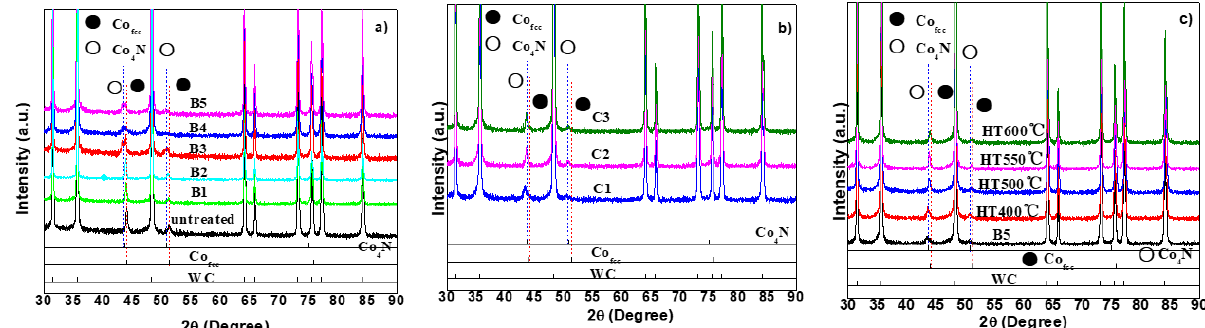
Figure 3. XRD patterns of the ( a ) and ( b ) plasma-nitrided specimens and the ( c ) annealed specimen B5#. Figure 4 presents the XPS core-level spectra of specimen B5#; the spectra of the other specimens were similar. The peaks centered at binding energies of 781.03 and 796.83 eV in Figure 4a correspond to Co 2p 3/2 and Co 2p 1/2 of the Co compounds, respectively [36–38]. The peak corresponding to metallic Co (~778 eV) was not observed in the Co 2p spectrum, indicating the complete conversion of Co present on the surface to Co 4 N after plasma nitriding [39]. In the N 1s spectrum, the peak at 397.12 eV corresponds to the Co-nitrides and that at the 399.28 eV peak originates from the absorption of NH x or N 2 [39,40]. This suggests that Co–N bonds are dominant on the surface. Therefore, the thickness of the top Co 4 N layer is considered to be greater than the depth of analysis for the XPS measurement.